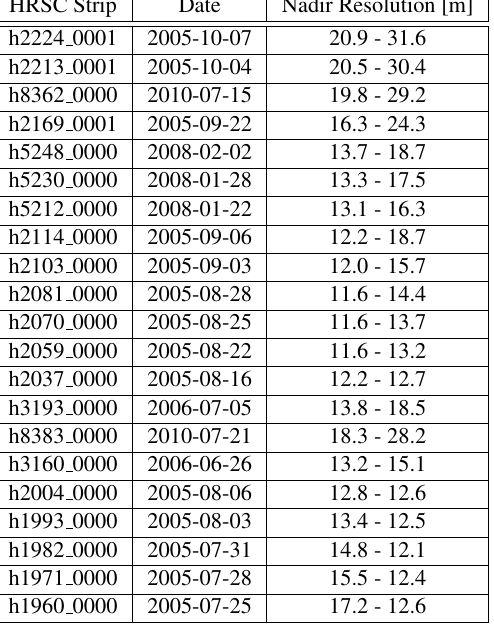
Table 1: HRSC strips used for the block